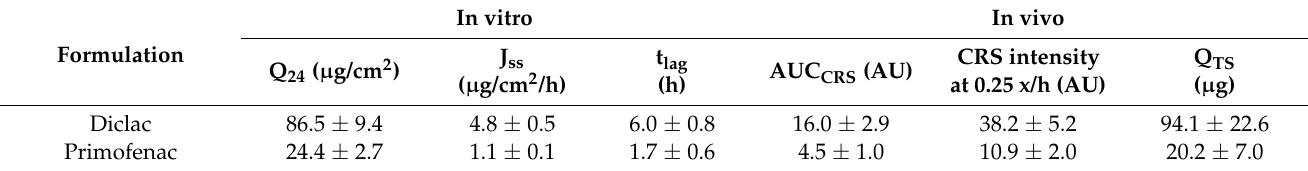
Table 2. Comparison of skin permeation parameters for Diclac ® and Primofenac ® , measured by the in vitro permeation model, confocal Raman spectroscopy in vivo and tape stripping in vivo. In vitro In vivo Formulation Q 24 ( µ g/cm 2